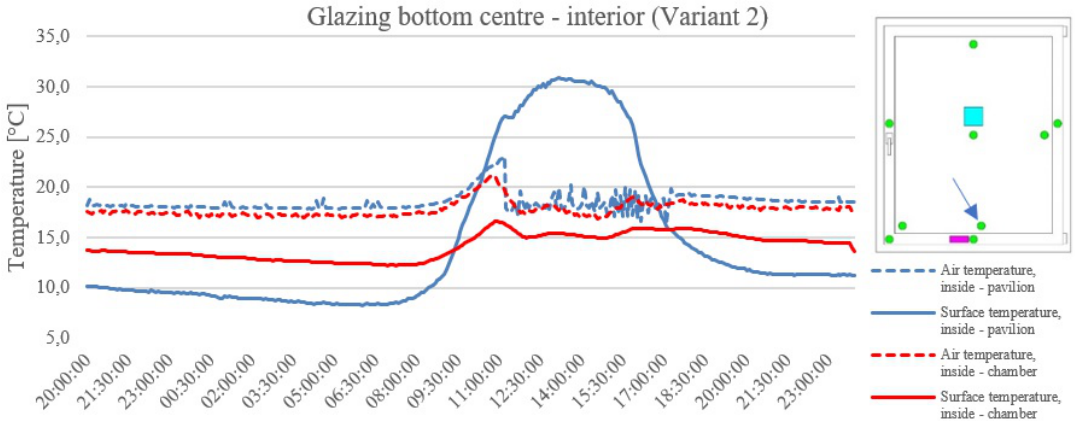
Figure 5. Temperatures courses for the bottom of glazing. Variant 2 with non-steady indoor temperature. Difference of about 4 °C in surface temperatures.